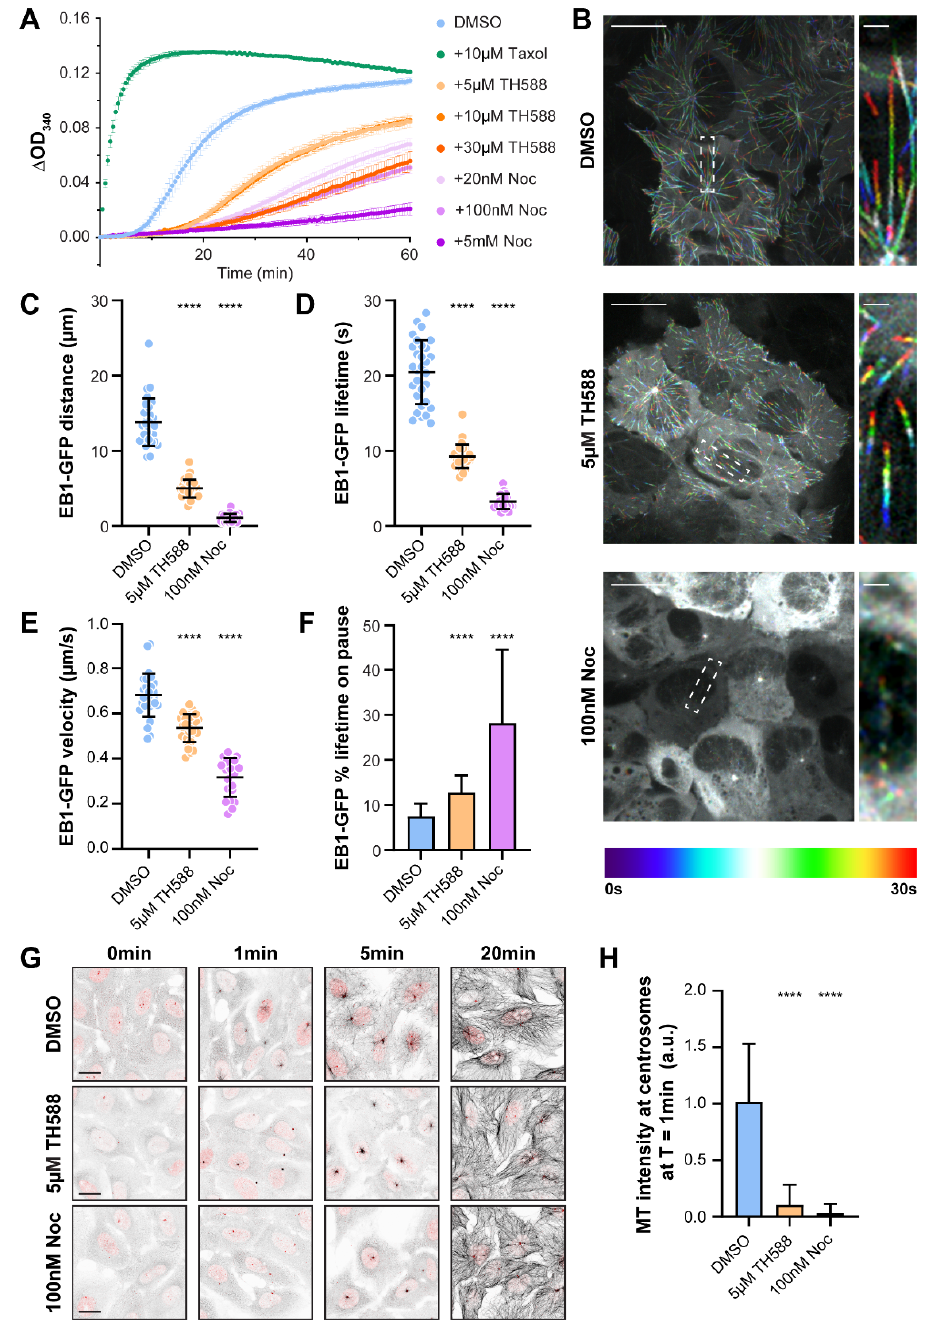
Figure 1. TH588 disrupts in vitro MT polymerization and in cellulo MT nucleation and reduces MT dynamics in interphase cells. ( A ) Turbidimetry-based in vitro tubulin polymerization assay